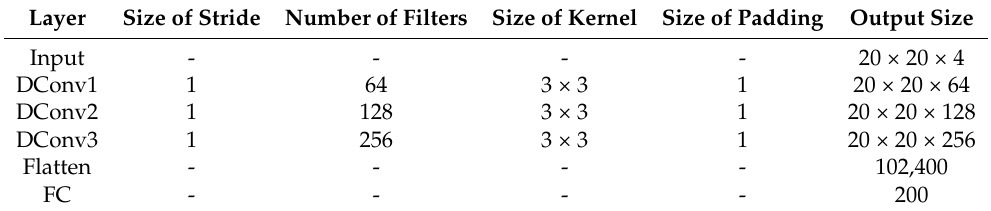
Figure 1. Overview of DyConvNE. In the DyConvNE model, the head and relation embeddings are first reshaped into four permutation matrices. Then, these matrices are used as an input to the dynamic convolutional layer. The resulting feature map tensors are flattened and projected in a 200-dimensional space and matched with all candidate object embeddings. Please refer to Section 3.2 for details. Table 1. Parameter settings for our